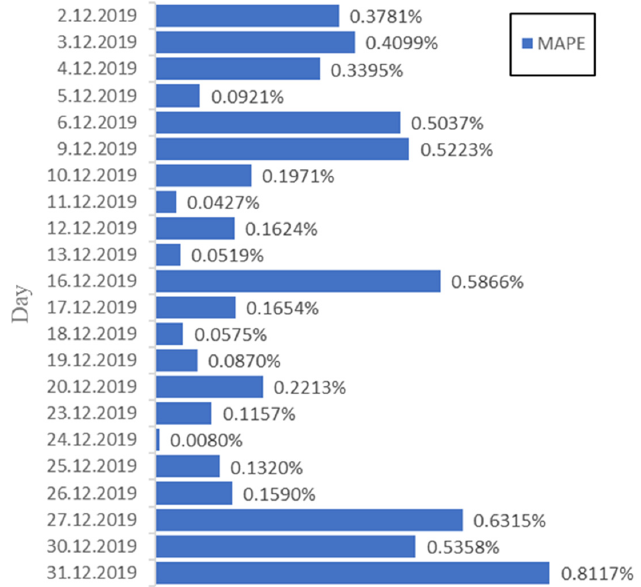
Figure 8. MAPE of the 22